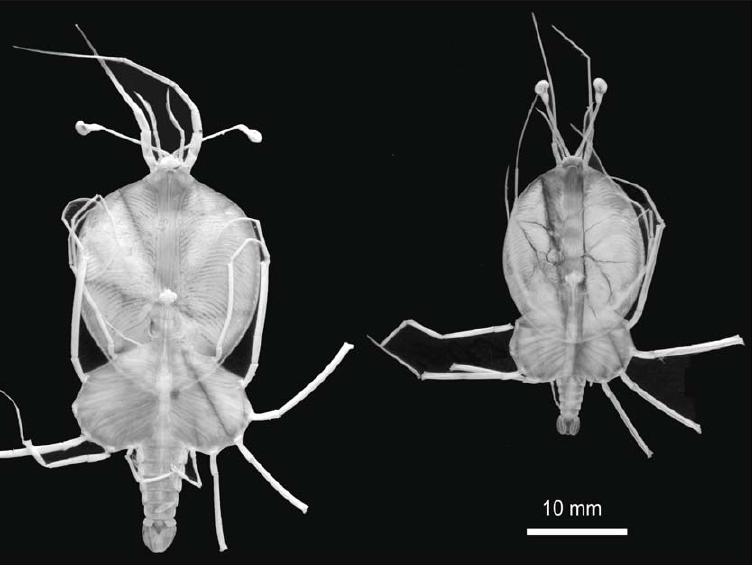
Figure 2. Two types of phyllosoma larvae of the genus Panulirus observed in the plankton samples collected in the western waters of Gala´pagos Islands. Both are final stage and the left one was morphologically identified to be Panulirus penicillatus but the right one could not be identified to a species.